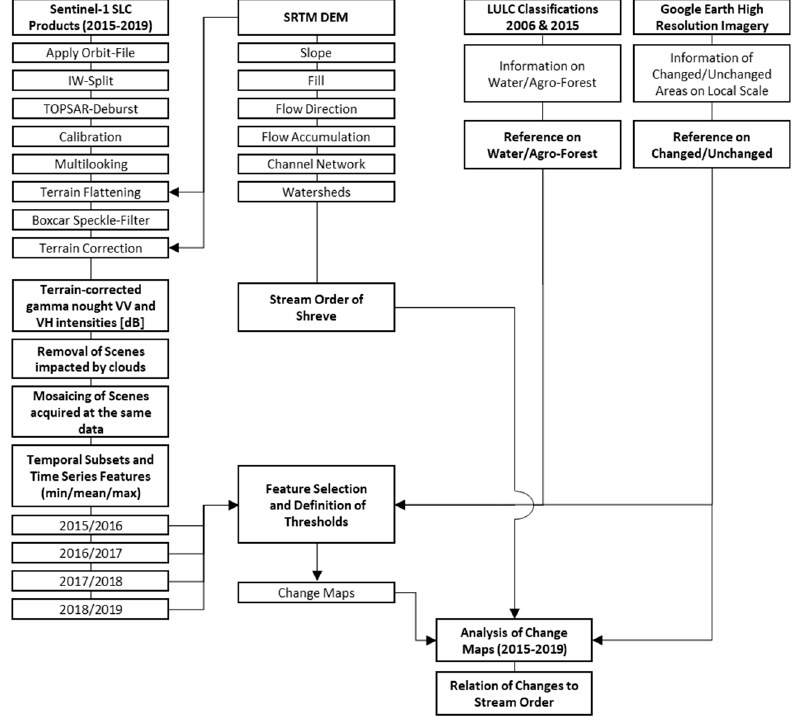
Figure 2. Schematic workflow of the processing and analysis of Sentinel-1 time series, the Shuttle Radar Topographic Mission (SRTM) digital elevation model and the reference datasets.